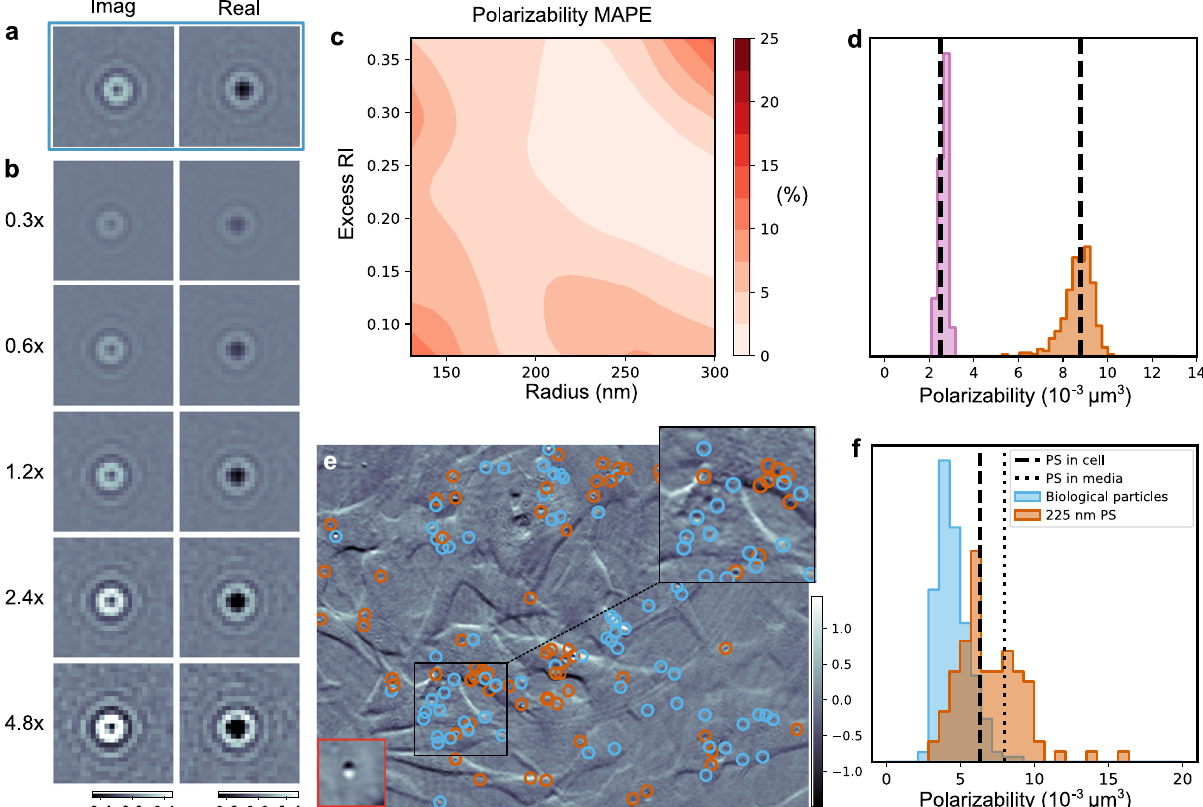
around SH-SY5Y human neuroblastoma cells imaged through an off-axis holo- graphy microscope. LodeSTAR, trained on a single image (bottom left), learns to detect and measure the fl uorescent particles (orange markers) as well as the non- fl uorescent intracellular particles(blue markers).See also SupplementaryMovie 8. f Thedistributionsofthemeasuredpolarizabilityoftheparticlesandthebiological particles are drawn from two distinct distributions, indicating that we successfully separate theaddedpolystyrene particles from the biologicalparticles. The peakof the distribution matches the expected polarizability of polystyrene inside of cells (dashedline),alessprominentpeakneartheexpectedpolarizabilityofpolystyrene outside of cells (dotted